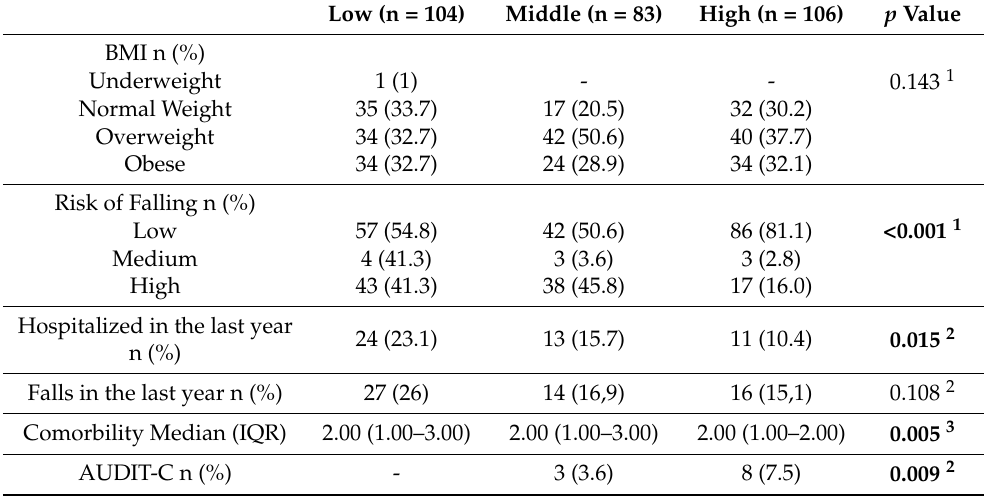
Table 3. Physical variables based on the level of acceptability of the use of new technologies. Low (n = 104) Middle (n =